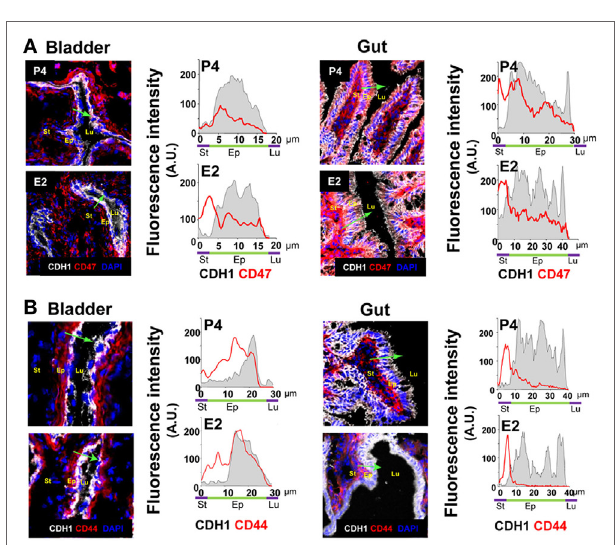
FigUre 9 | Bilaterally ovariectomized mice received hormone treatment subcutaneously ( n = 5). (a) Bladder and gut CD47-stained. CD47 expression in the epithelium (CDH1 + ) cross section. (B) Bladder and gut CD44-stained. CD44 expression in the epithelium (CDH1 + ) cross section. Green arrow shows the cross section direction. Scale bar, 200 µm. E2, estradiol; P4, progesterone. Abbreviation: A.U., arbitrary units; Lu: lumen; Ep: Epithelium; St: